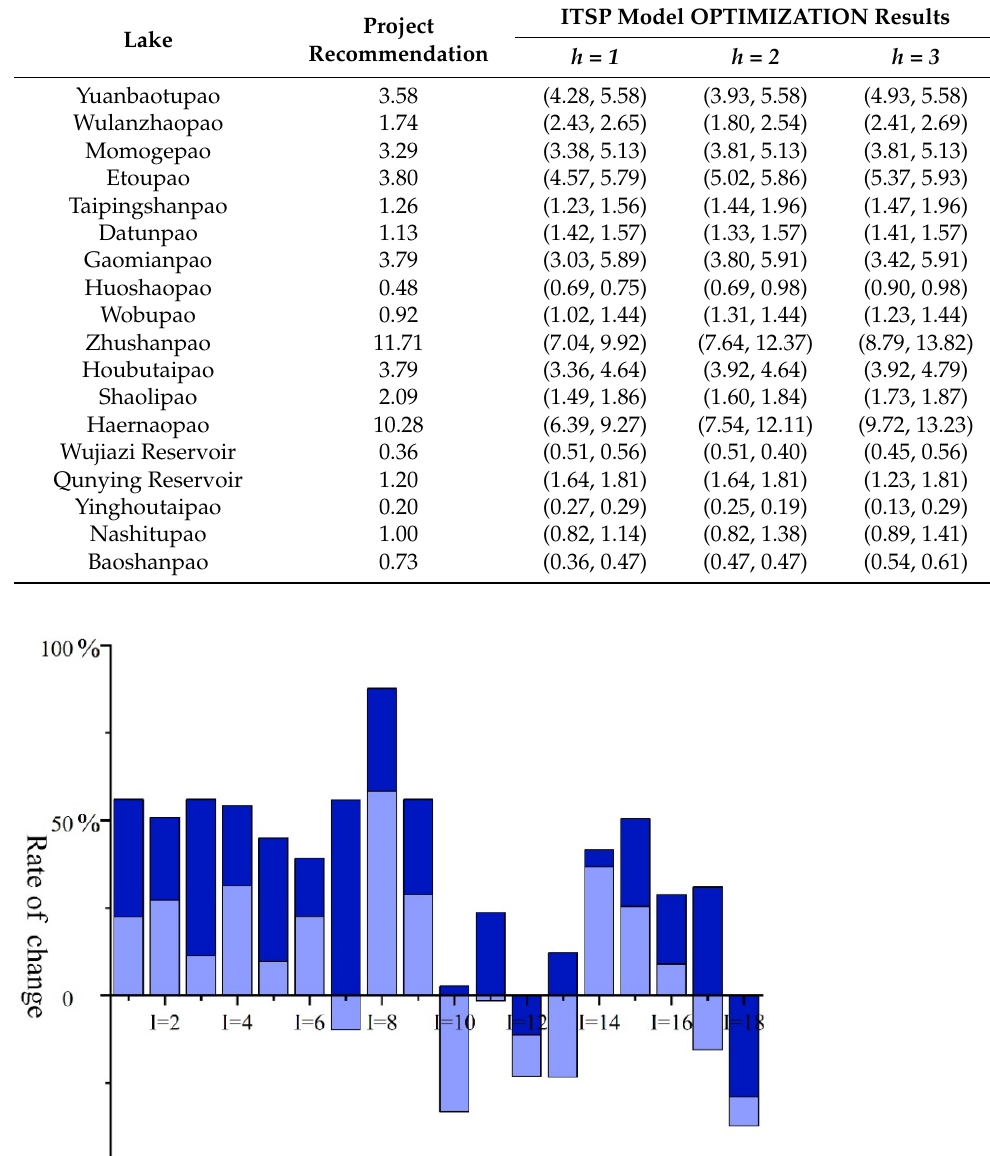
Table 2. Changes in the functional area of each lake in the nature reserve prior to and after the ITSP model optimization ( × 10 4 hm 2 ).